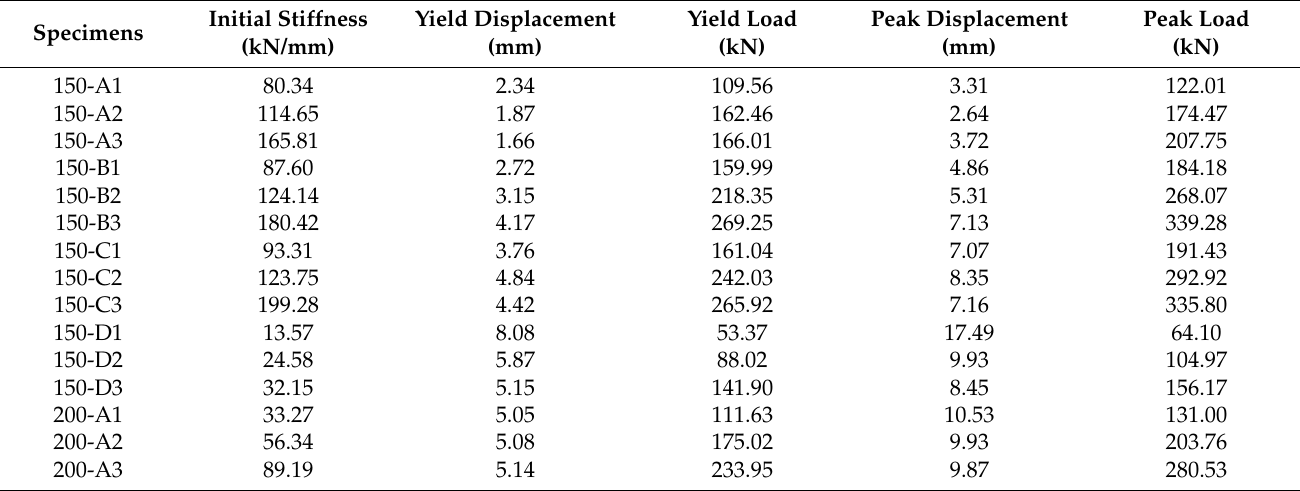
Table 3. Characteristic load and displacement of seamless steel tube